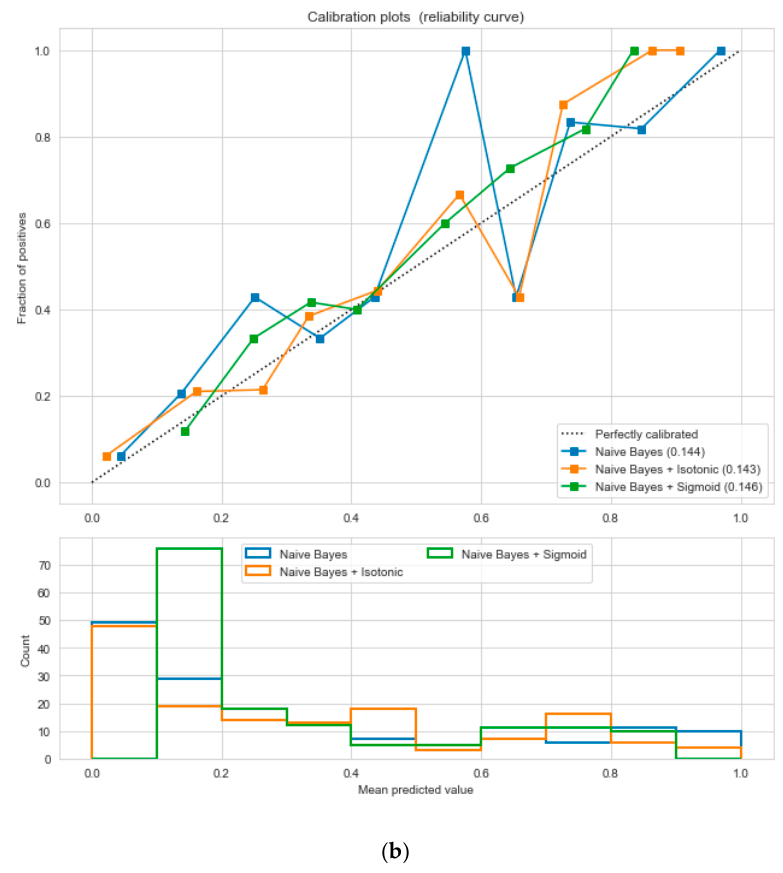
Figure 16. ( a ) Reliability curve to classify the “Diabetes” data with different ML classifiers. ( b ) Reliability curve to classify the “Diabetes” data with the “Calibrated LR”.